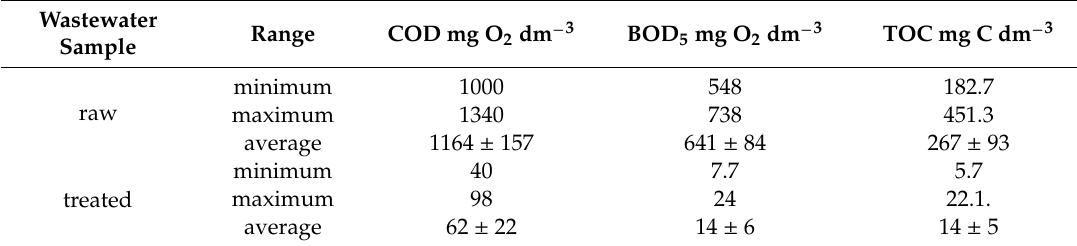
Table 3. Characterization of organic waste in raw and treated